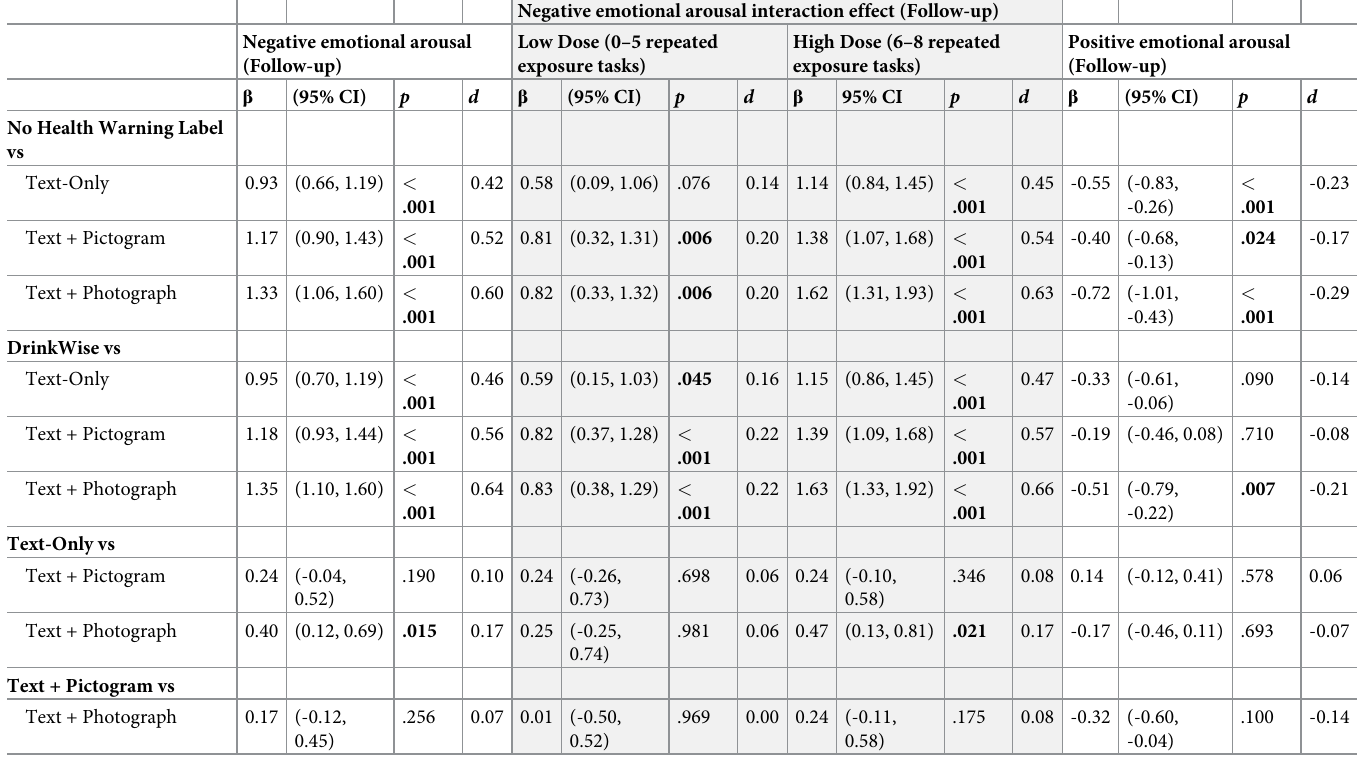
Table 4. Pairwise comparisons for negative emotional arousal and positive emotional arousal.